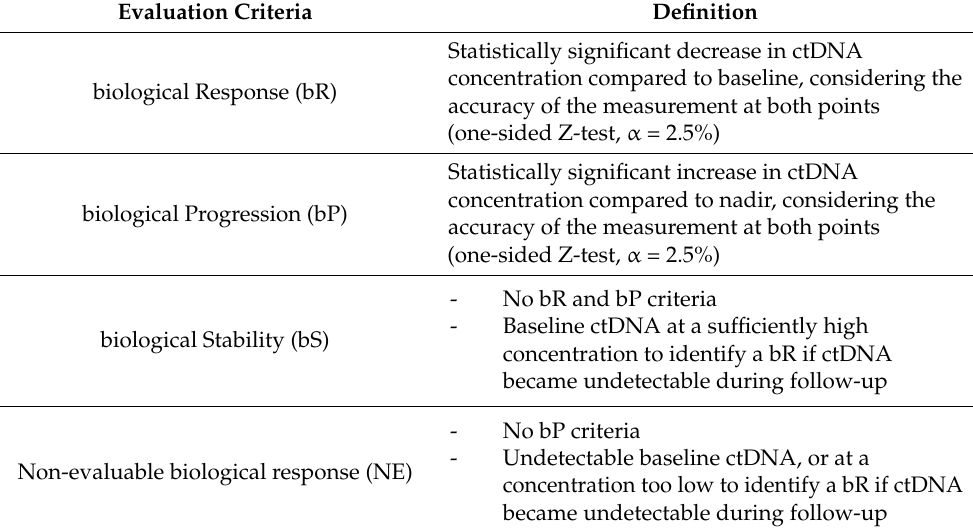
Table 1. Biological evaluation